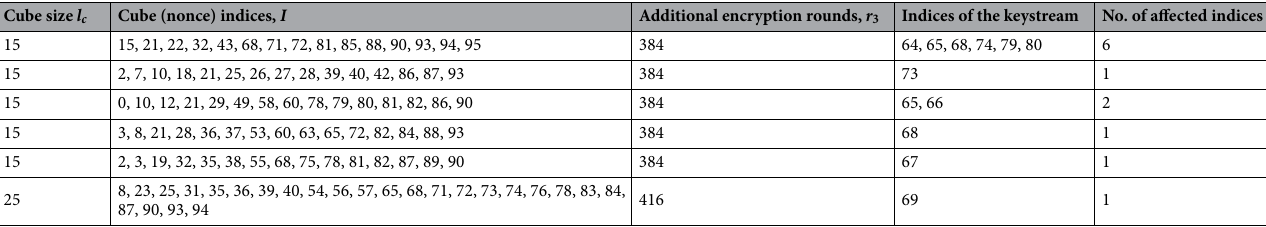
Table 6. Examples of cube testers found using DA2 with full cube space V { 0 ··· 95 } .